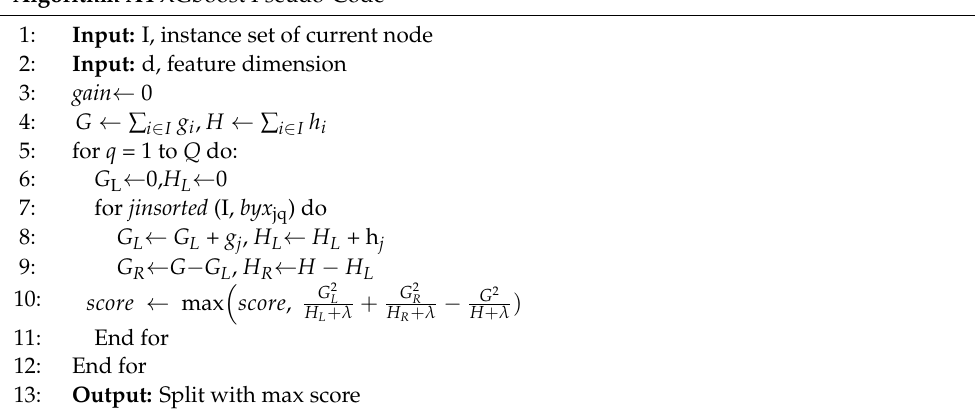
Algorithm A4 XGboost